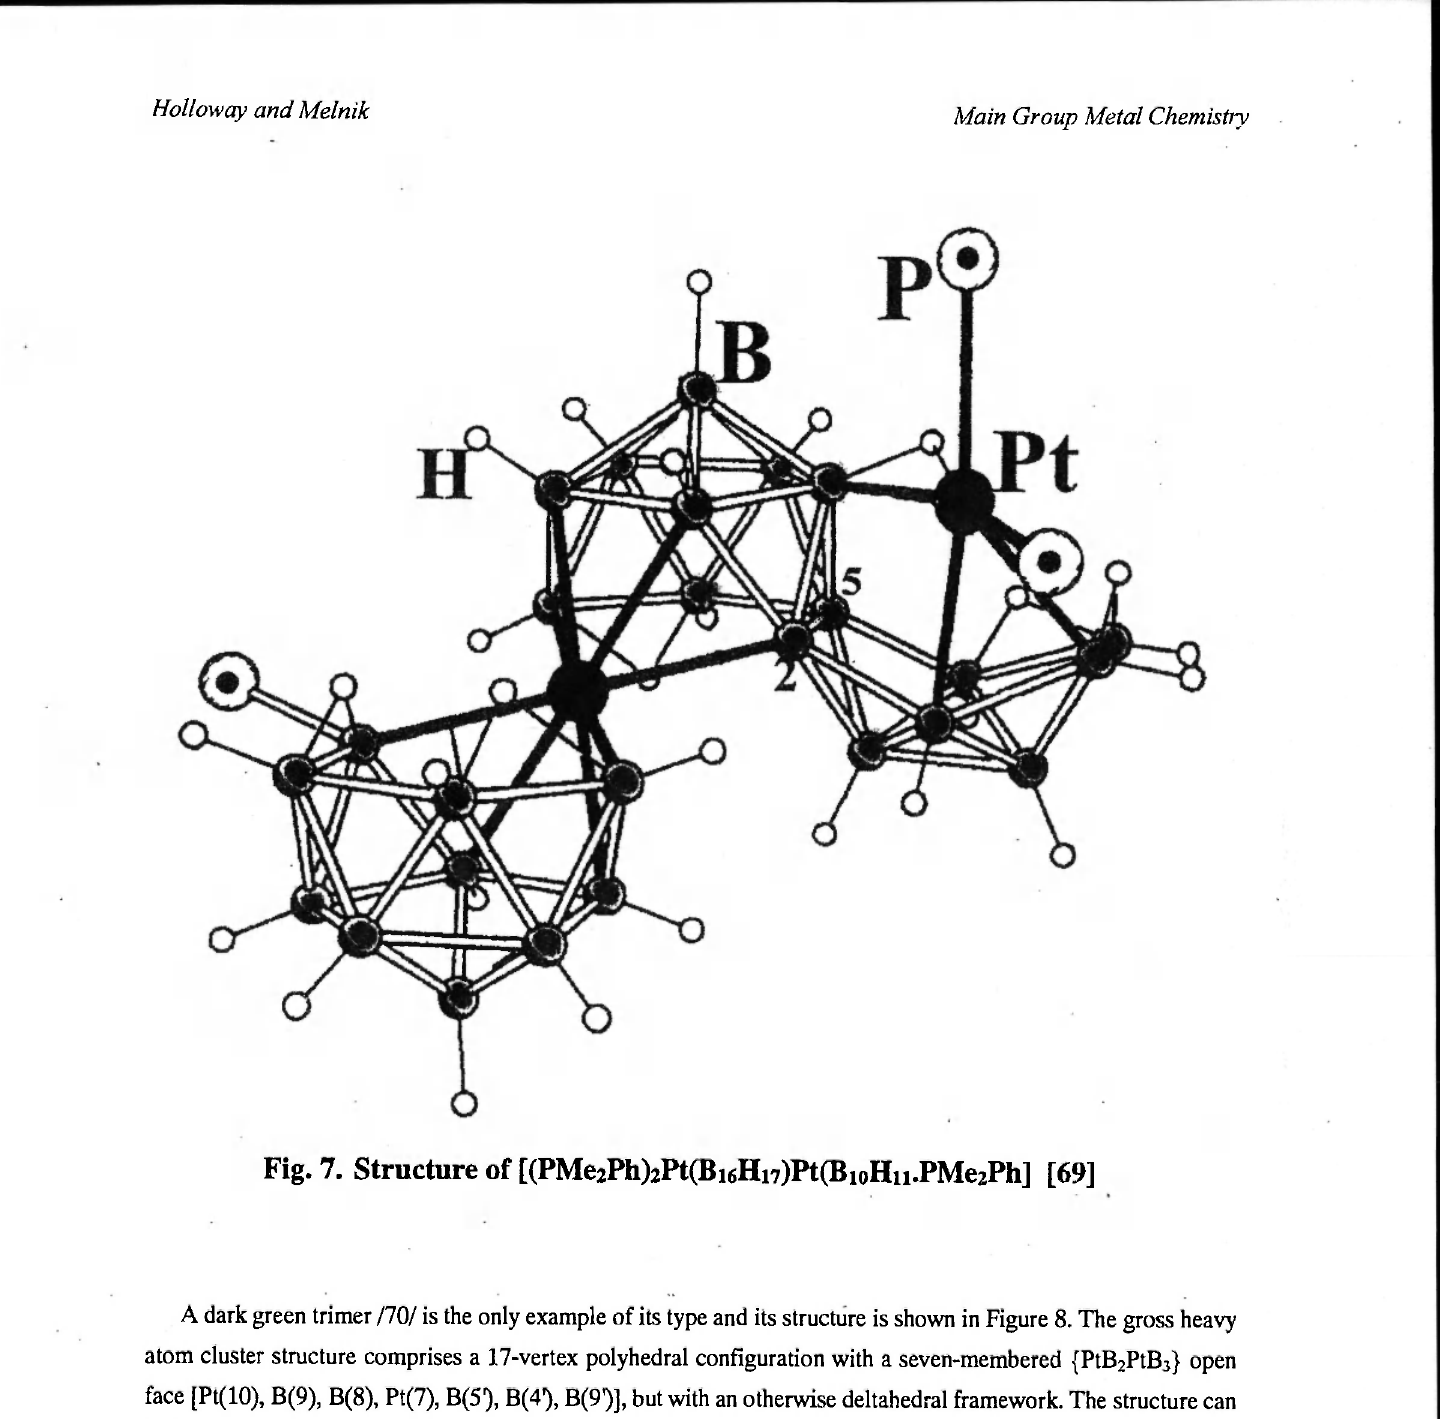
Fig. 7. Structure of [(PMe2Ph)